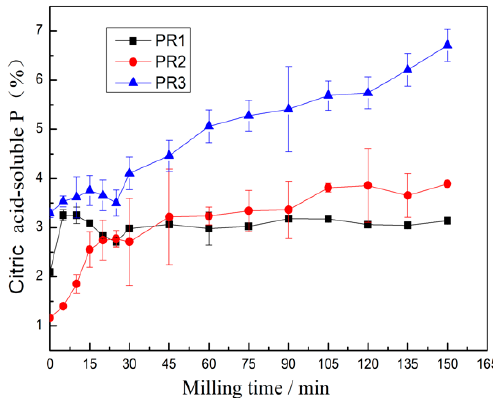
Figure 9. Changes of the citric acid-soluble P content with milling time.